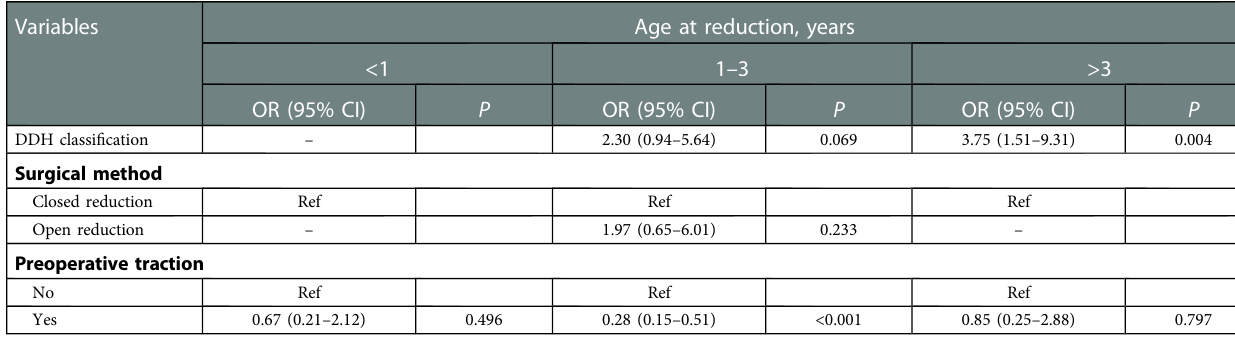
TABLE 4 Association of DDH classi fi cation and preoperative traction with ANFH in age at reduction subgroups. Variables